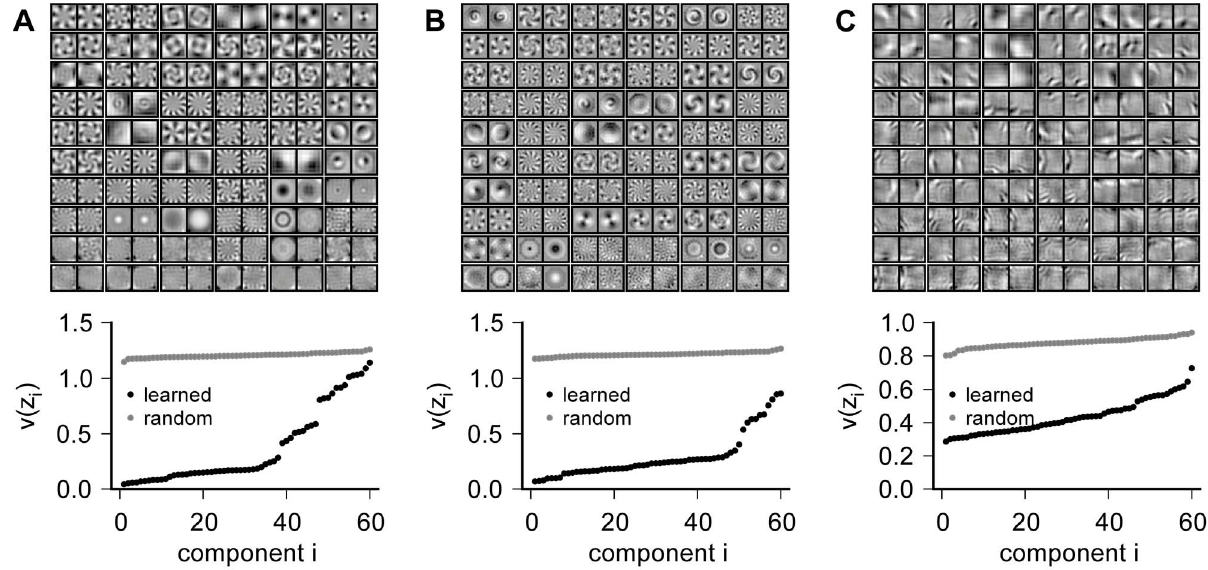
Figure 4. SSA filters for local rotation and scaling. Illustration of the filters obtained from patch-centered rotation sequences (A,B) and patch- centered scaling sequences (C) with the slowness of the individual filter subspaces before ( random ) and after the optimization ( learned ). The filters are ordered in ascending inverse slowness v (row-wise) with the slowest feature in the upper left and the fastest feature in the lower right corner. The data in (A) and (C) consist of 11 | 11 square patches from the van Hateren data set while the data for (B) consist of 121-dimensional round patches which are, for visualization, embedded in a 14 6 14 square patch. The rotation filters match those found in steerable filter theory [28]. The filters of the patch-centered anisotropic scaling exhibit localized edge filters centered towards the patch boundaries.